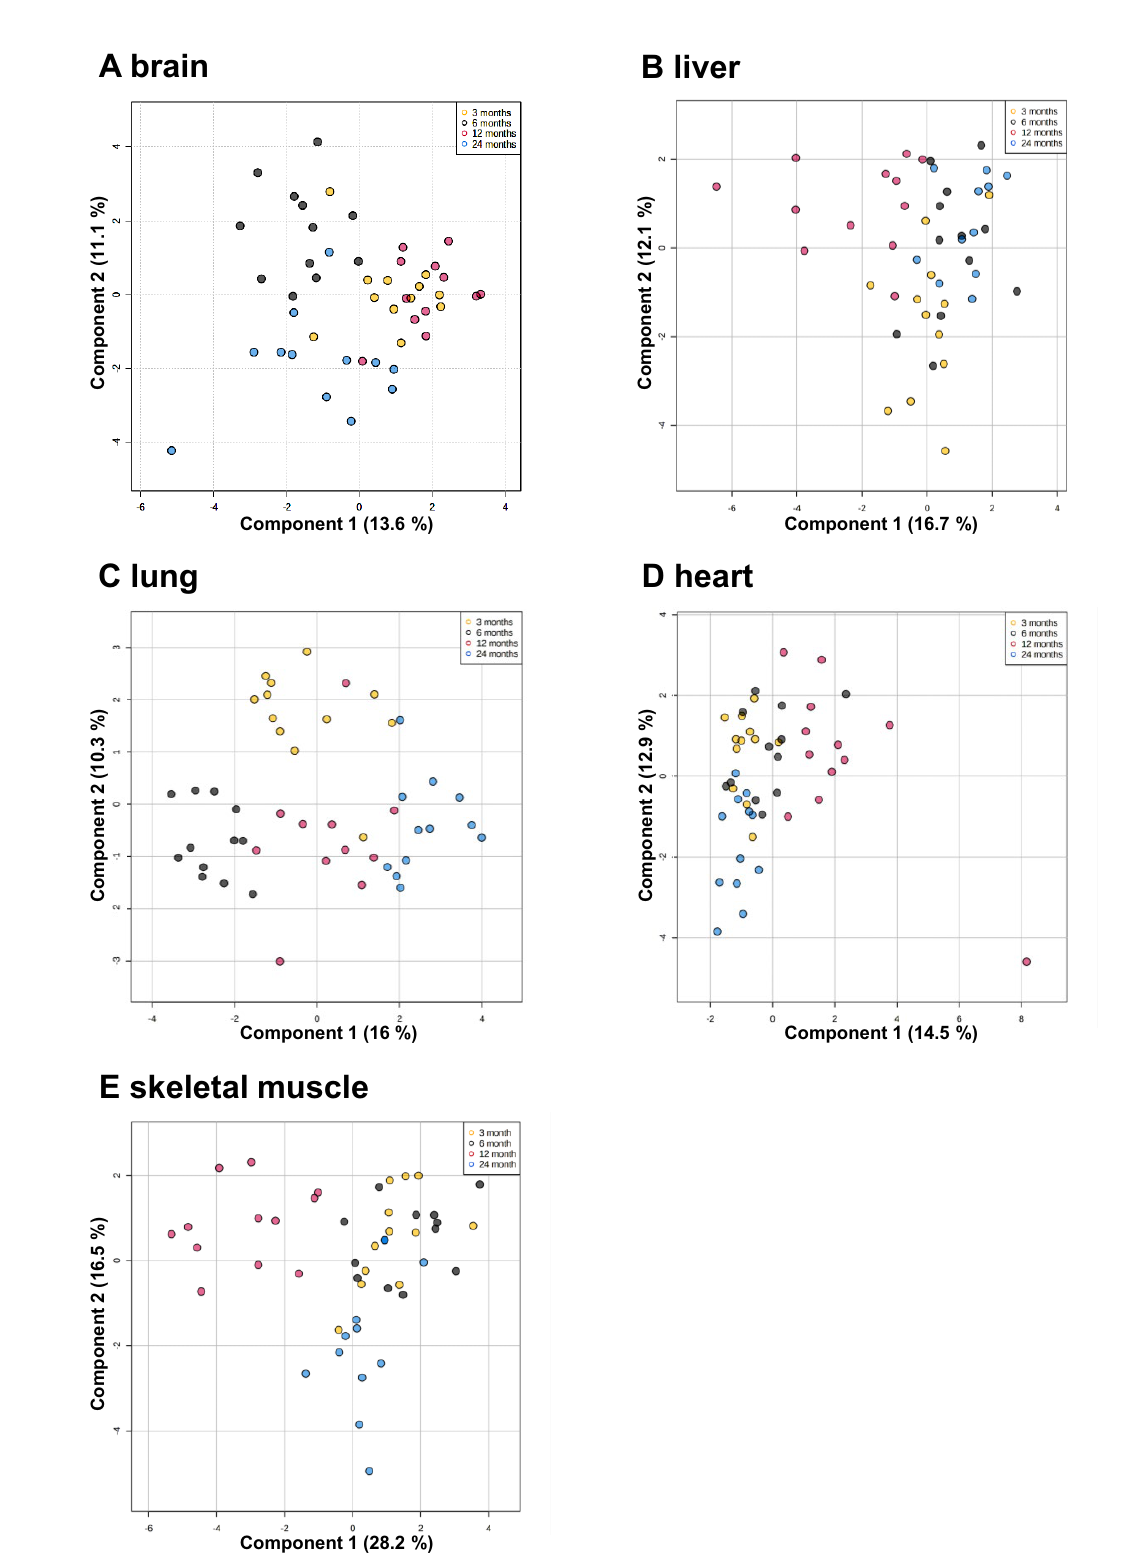
Figure 1. Age group clustering in different murine tissues. S-PLS-DA plot of the brain ( A ), heart ( B ), skeletal muscle ( C ), liver ( D ), and lung ( E ) tissue of six female and six male mice of different ages, including 3 months (1), 6 months (2), 12 months (3), and 24 months